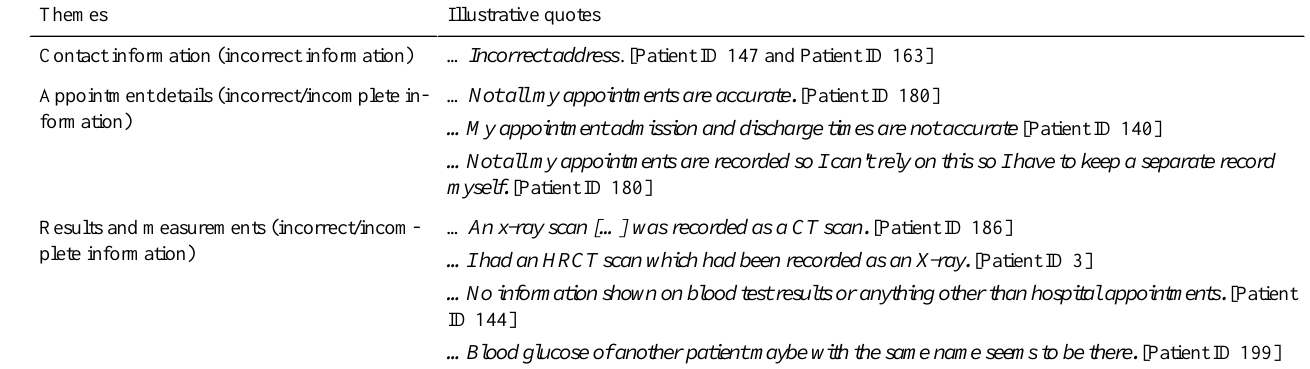
Table 2. Types of errors identified by patients within their electronic health